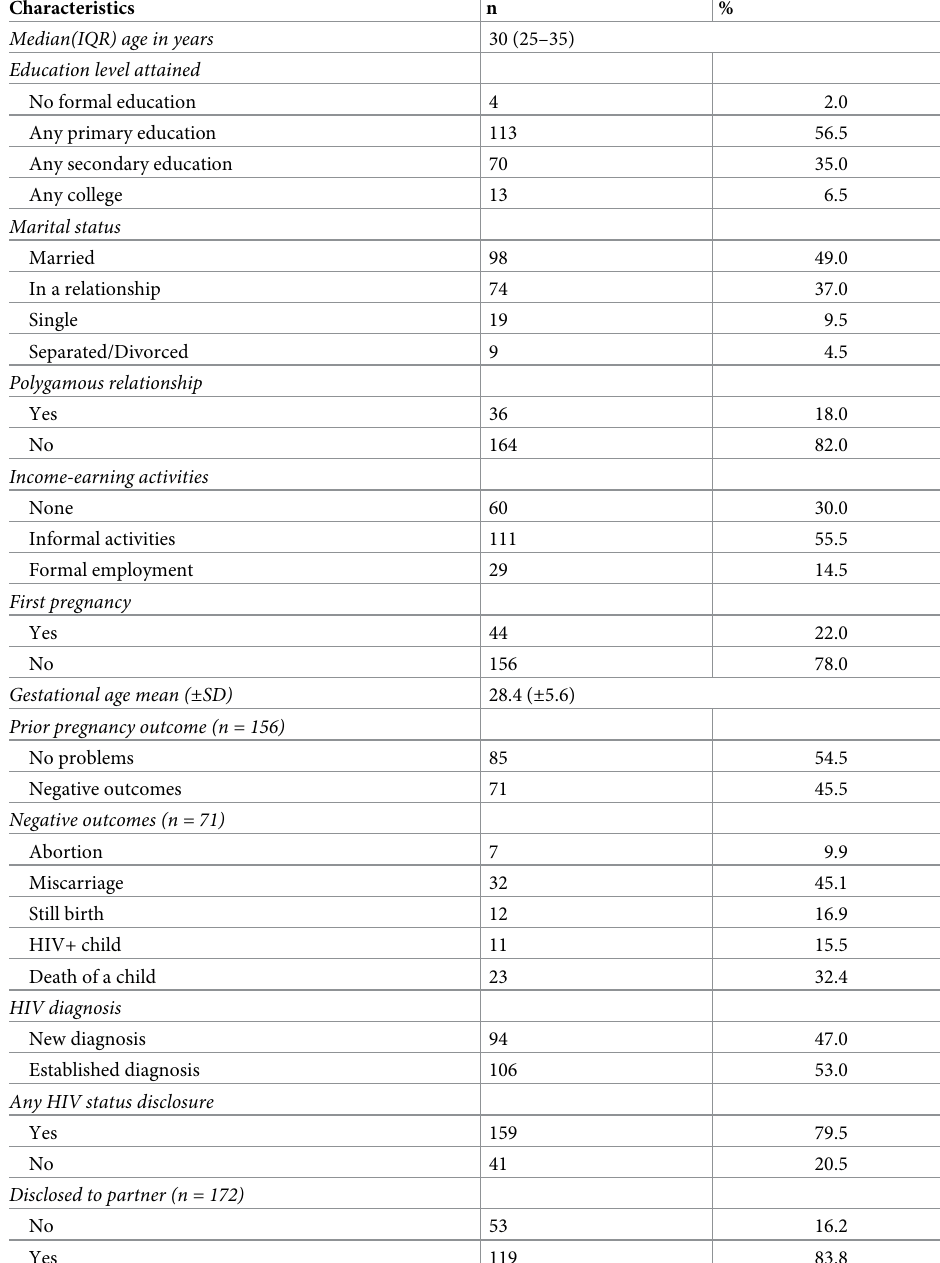
Table 1. Characteristics of study participants (n =